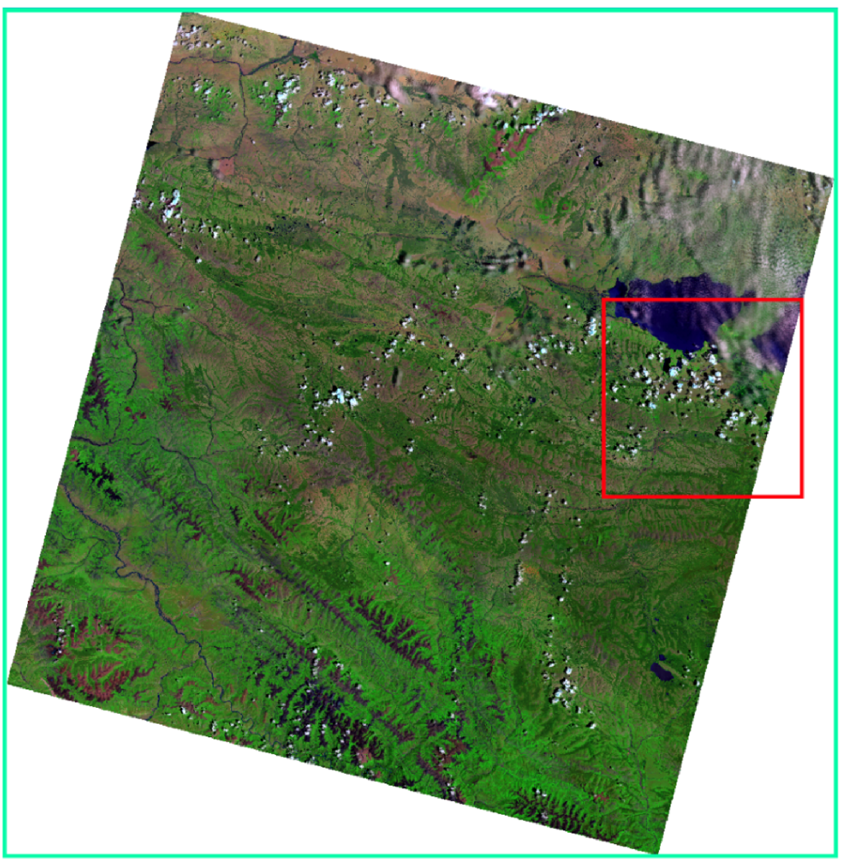
Figure 1. A representative Landsat-8 image with cloud cover after initial data preprocessing (17 July 2018, Path 135, Row 36 (WRS-2), Headwater of Huang River. Note that there are thin and scattered clouds in the red box).